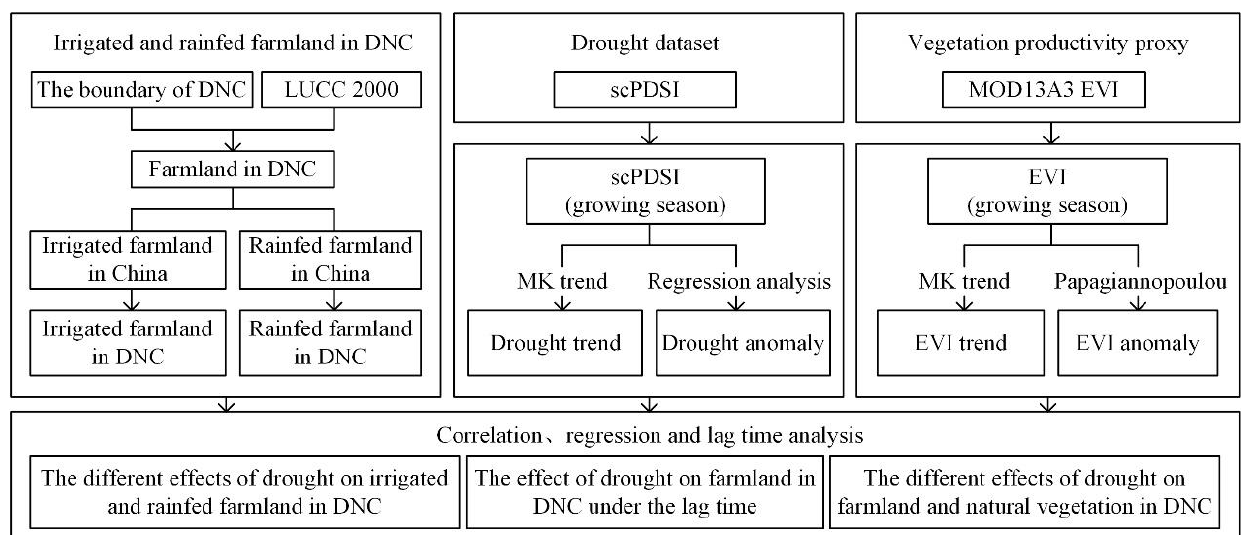
Figure 2. Methodology flowchart.